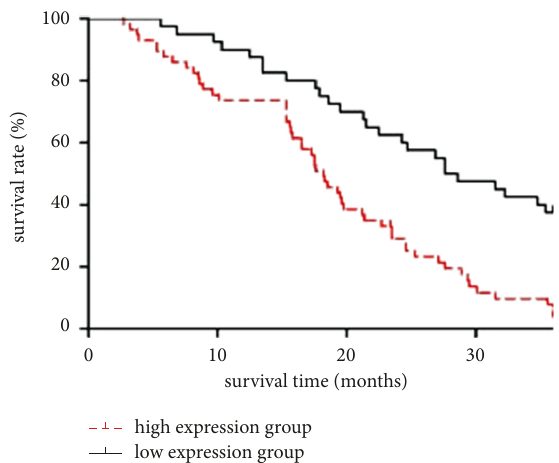
Figure 3: Survival curve analysis of patients with different ctDNA